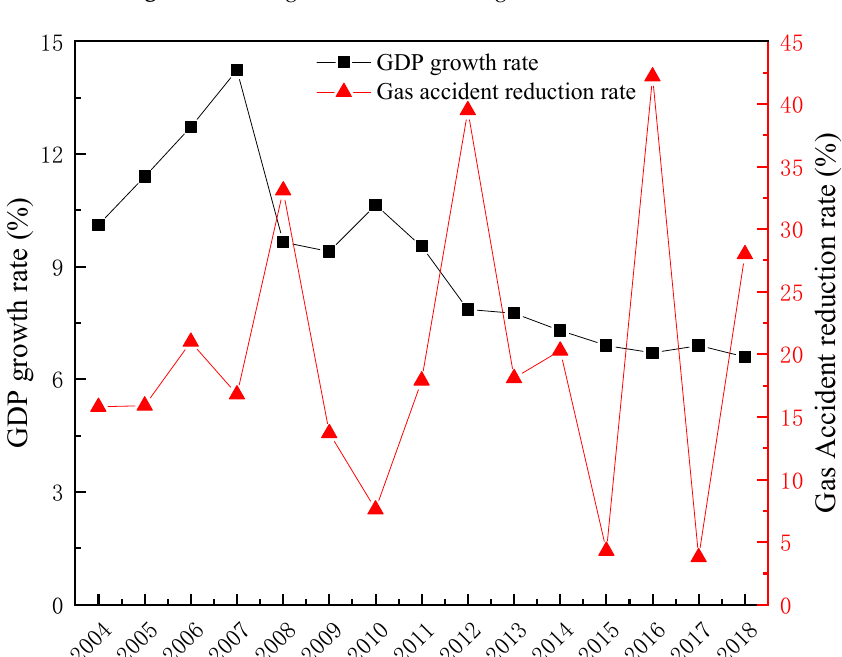
Figure 15. Changes in the growth rate of the GDP and the decline in the number of gas accidents.